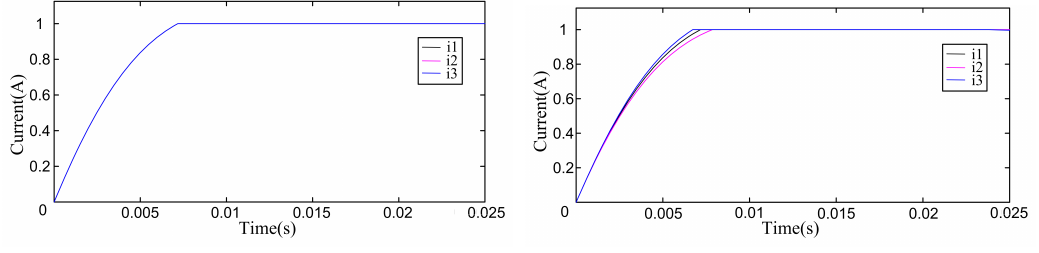
Figure 6. The three charging modules’ current of two methods.